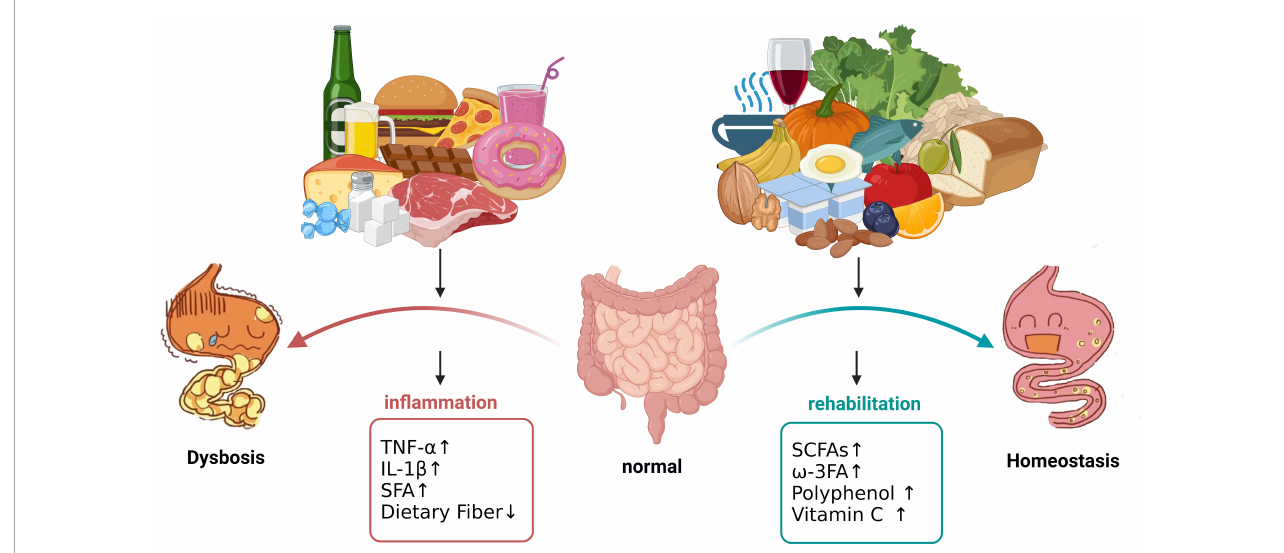
FIGURE1 Effect of different foods on the intestinal microenvironment. Consumption of sweetened processed snacks such as chocolate, candy, beverages, doughnuts, cheese, and high-fat, high-protein foods (burgers, pizza, and red meat) causes upregulation of the IBD-related inflammatory factors TNF- α and IL- β , thus increasing the risk of intestinal inflammation. Consumption of vegetables, fruits, roughage, tea, nuts, olive oil, fish and yogurt increases the expression of SCFAs and polyphenols, and powerful anti-inflammatory and antioxidant activities can help maintain intestinal microecological balance. The image created with